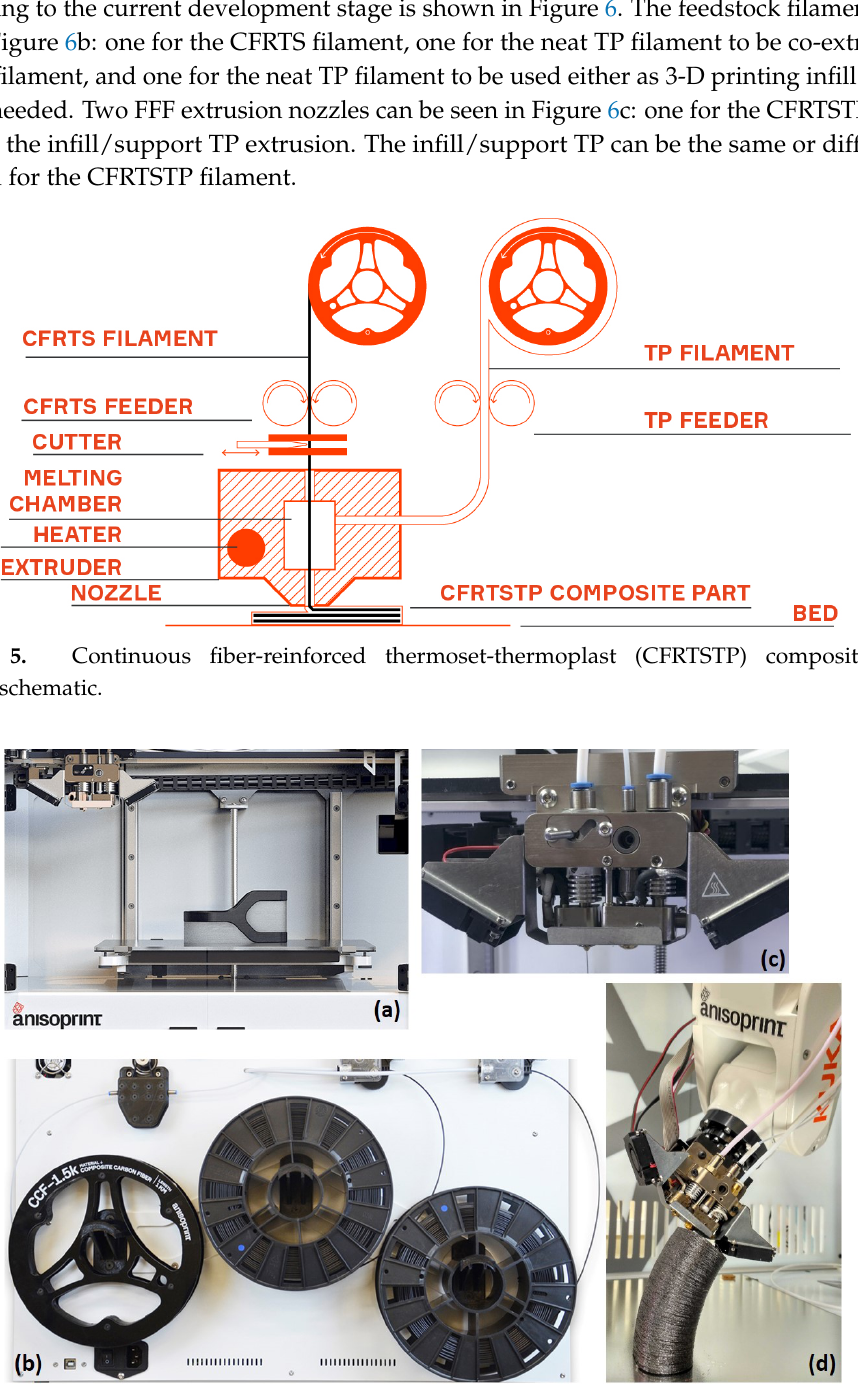
Figure 6. CFRTSTP composite 3-D printer design: ( a ) front view: 3-D printing volume; ( b ) back view: feedstock filaments roles; ( c ) composite extrusion head; and ( d ) extrusion head on a 5-axis robotic